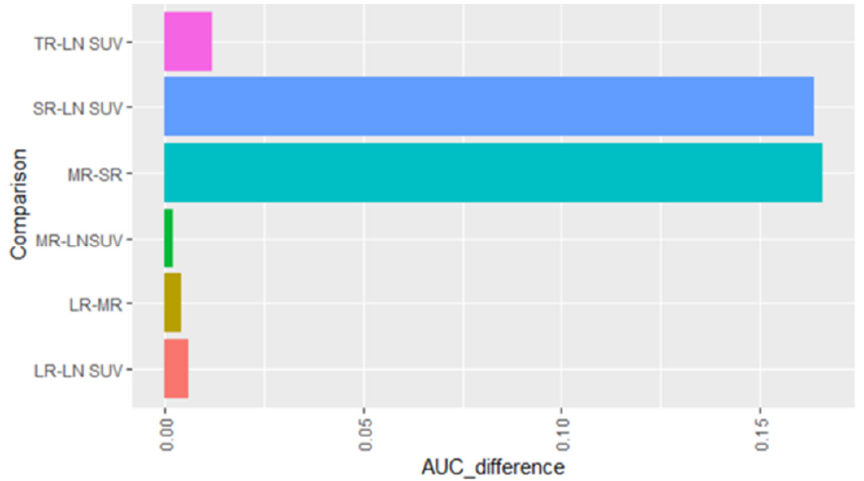
Figure 3. Pairwise analysis of AUC values of different ROC curves presented as bar graphs. TR = LN_SUVmax/Tumor_SUVmax; SR = LN_SUVmax/LN_Size; MR = LN_SUVmax/Mediastinum _SUVmax; LR = LN_SUVmax/Liver_SUVmax.